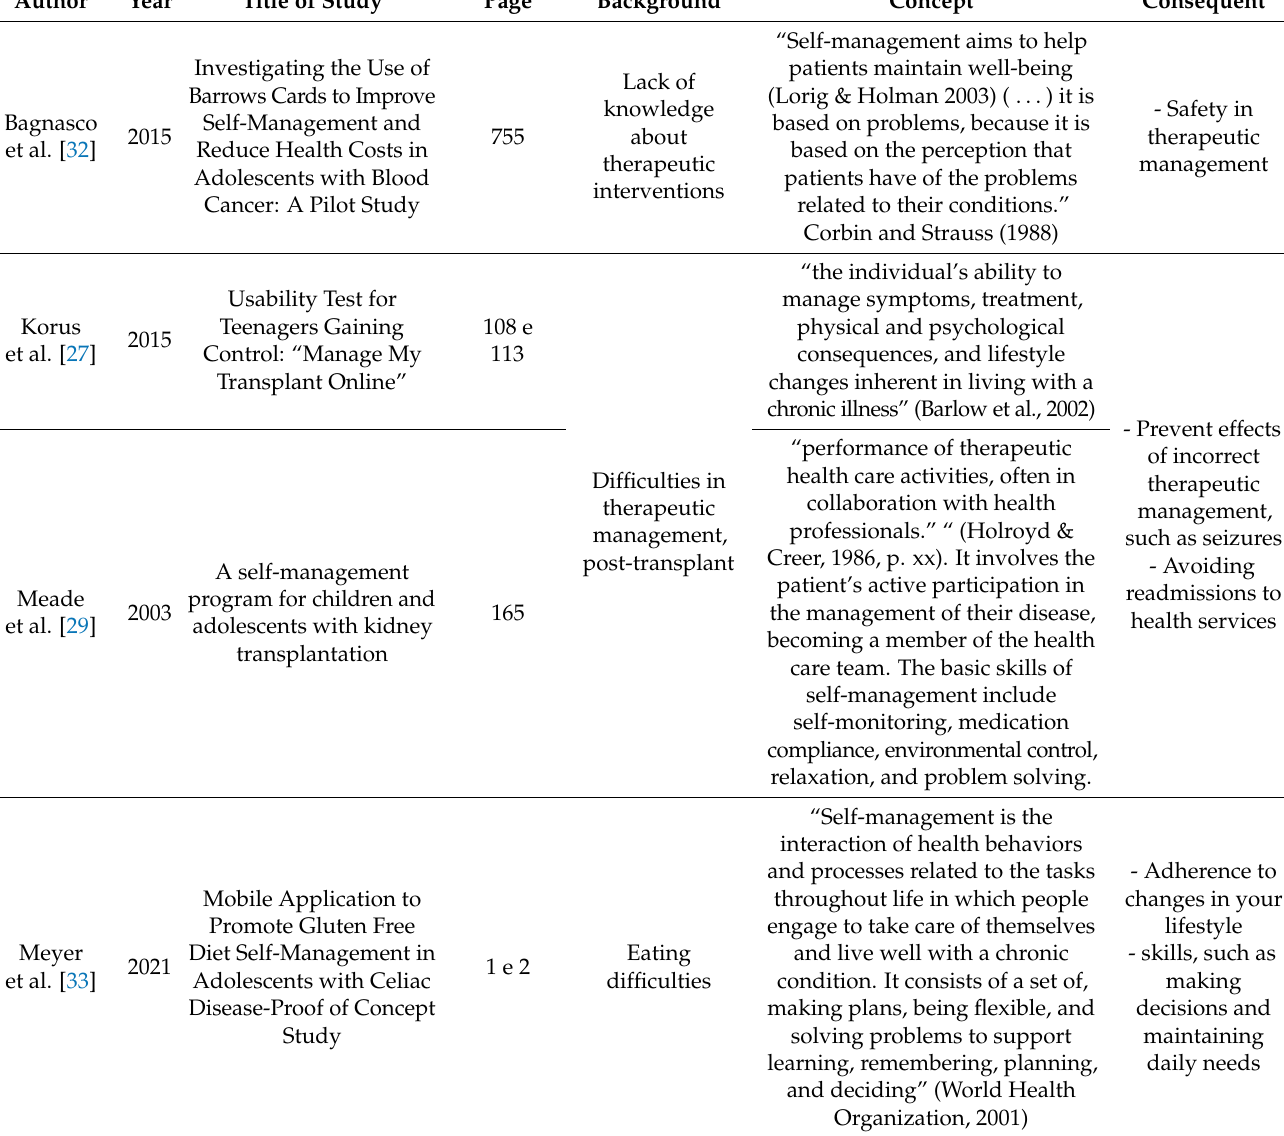
Table A4. Use of the concept of self-management of chronic illness in children and adolescents in the context of health care.